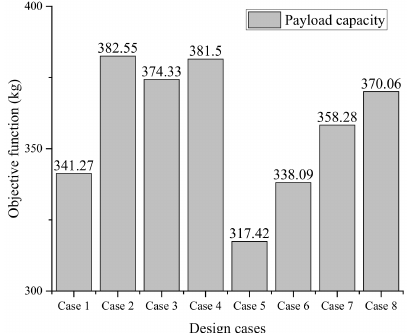
Figure 7. The optimal payload capacity of design cases.